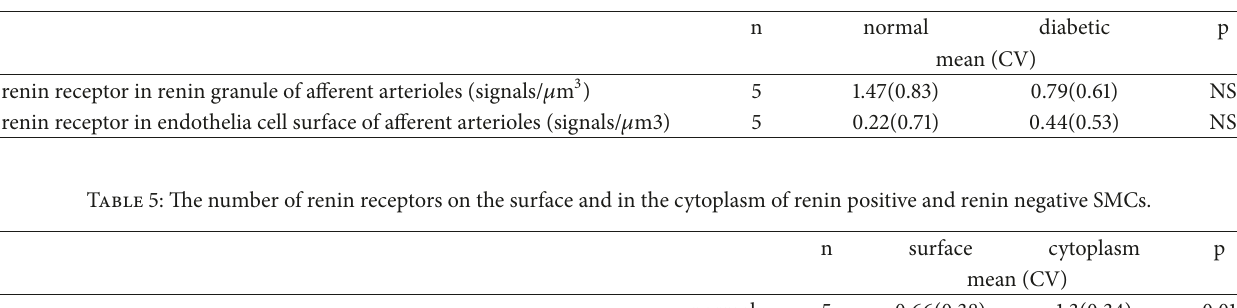
Table 4: The number of renin receptors in renin granules and on endothelial surfaces in normal and diabetic rats.